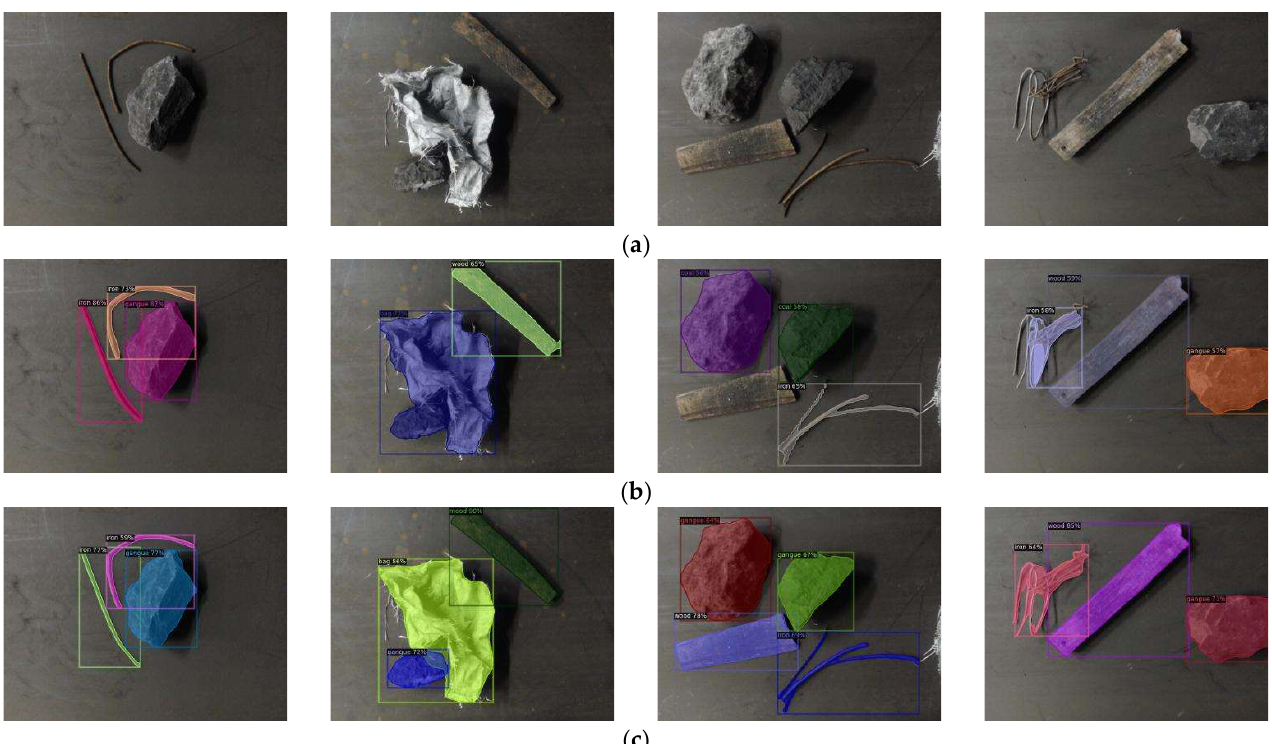
Figure 18. Comparison of detection effects before and after data augmentation. ( a ) Samples; ( b ) Before augmentation; ( c ) After augmentation.